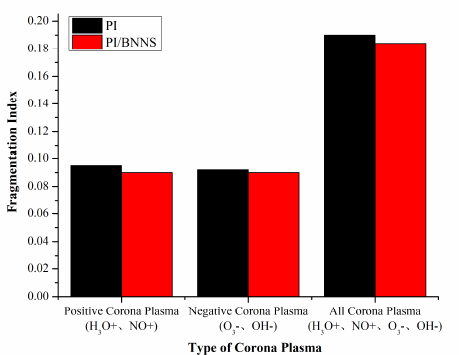
Figure 15. System fragmentation index under the effect of the different corona types at 100 ps.